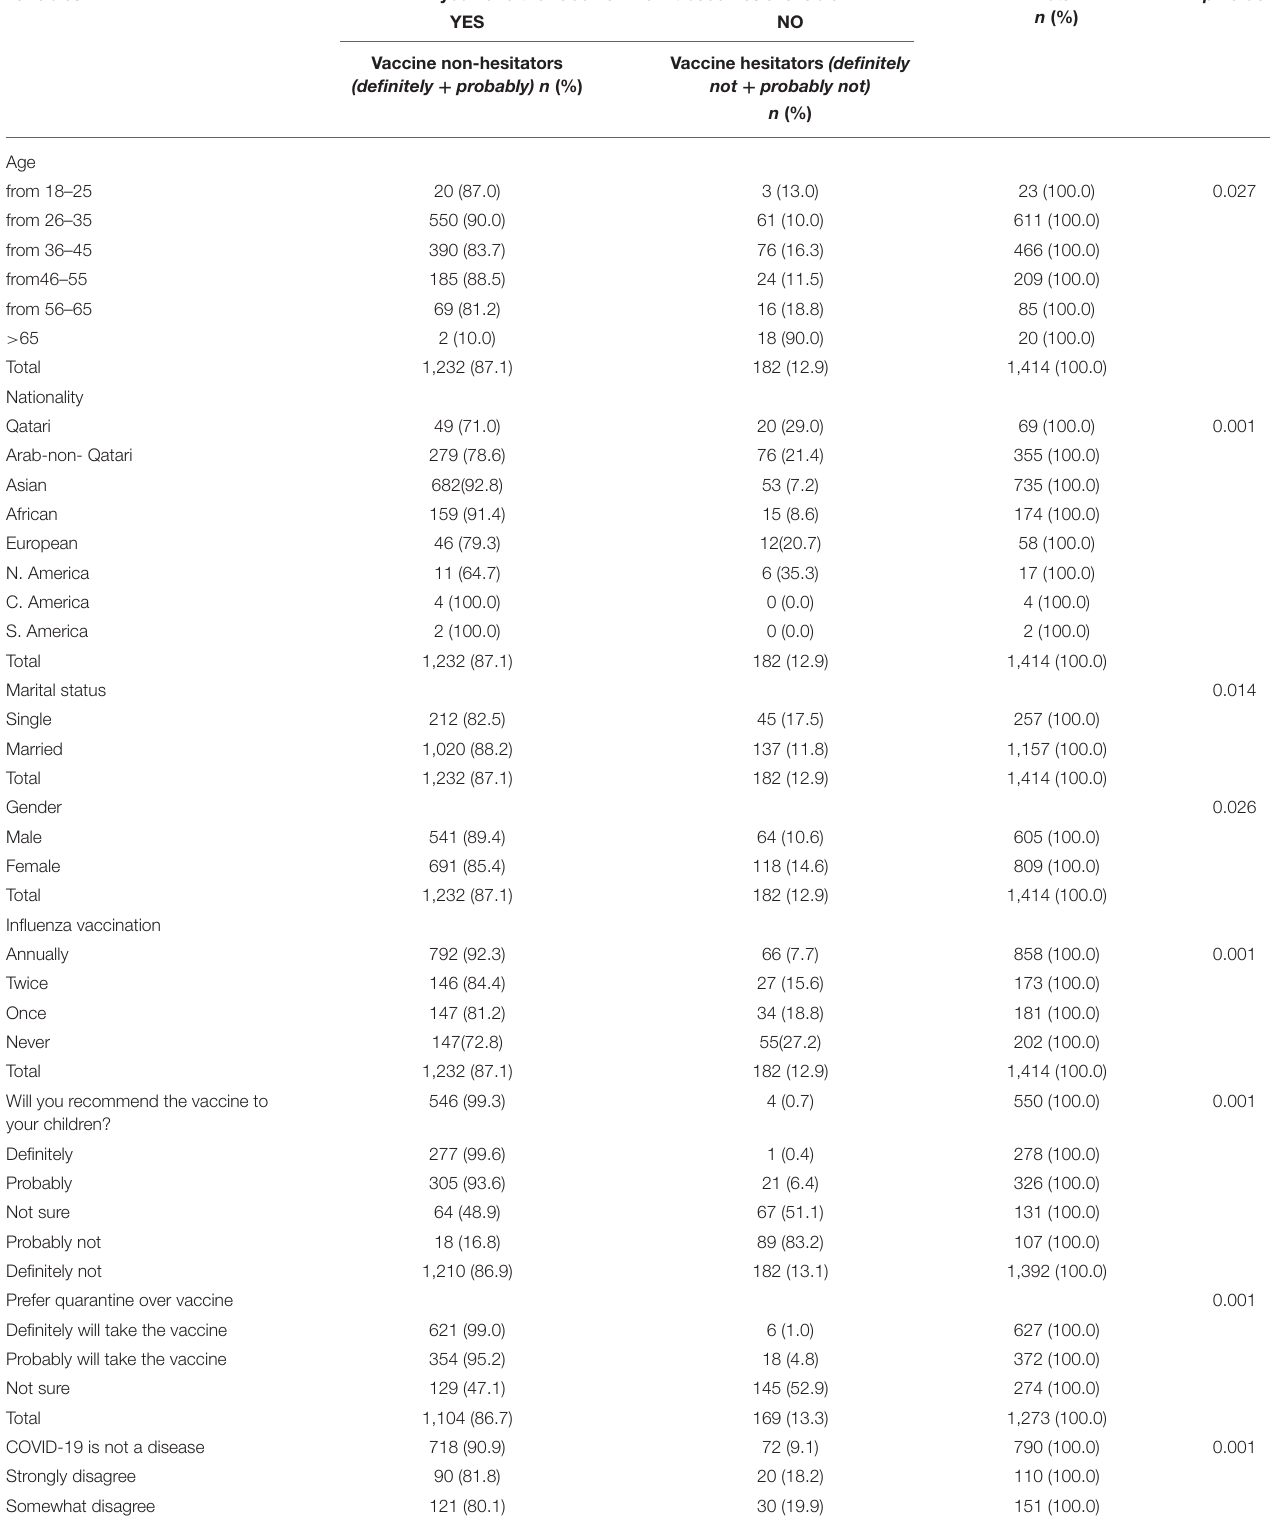
TABLE 3 | Univariate analysis of demographics, variables related to attitude and perception of vaccination, comparing vaccine hesitators and non-hesitators.